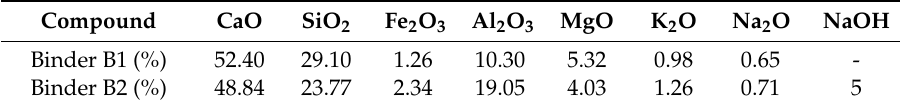
Table 4. Chemical composition of the